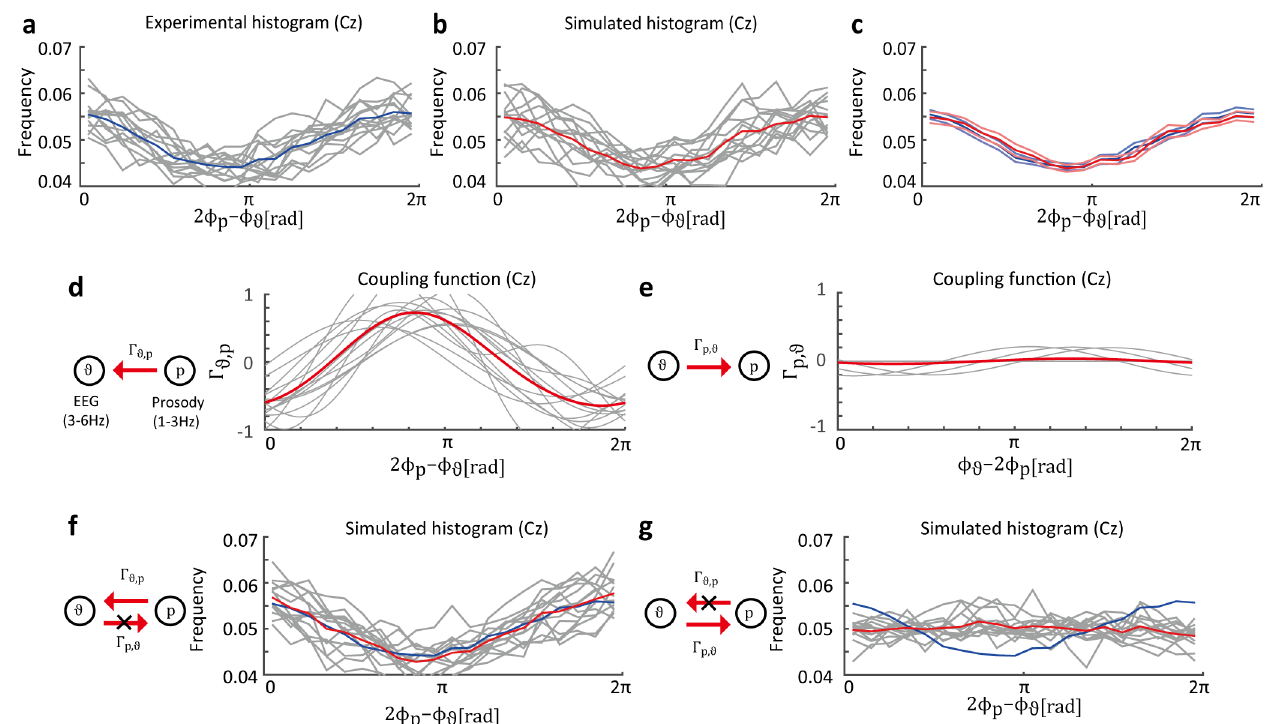
Fig 6. Estimated distribution of phase difference between EEG data and prosody envelope. (a) Experimental phase difference histograms for 1:2 phase locking. (b) Simulated histograms based on the estimated phase oscillator model. (c) Blue lines represent the average and SEM of experimental phase difference histograms. Red lines represent the average and SEM of simulated histograms. (d) Estimated coupling functions Γ θ , p . (e) Estimated coupling functions Γ . (f) Simulated histograms where coupling functions Γ p , θ